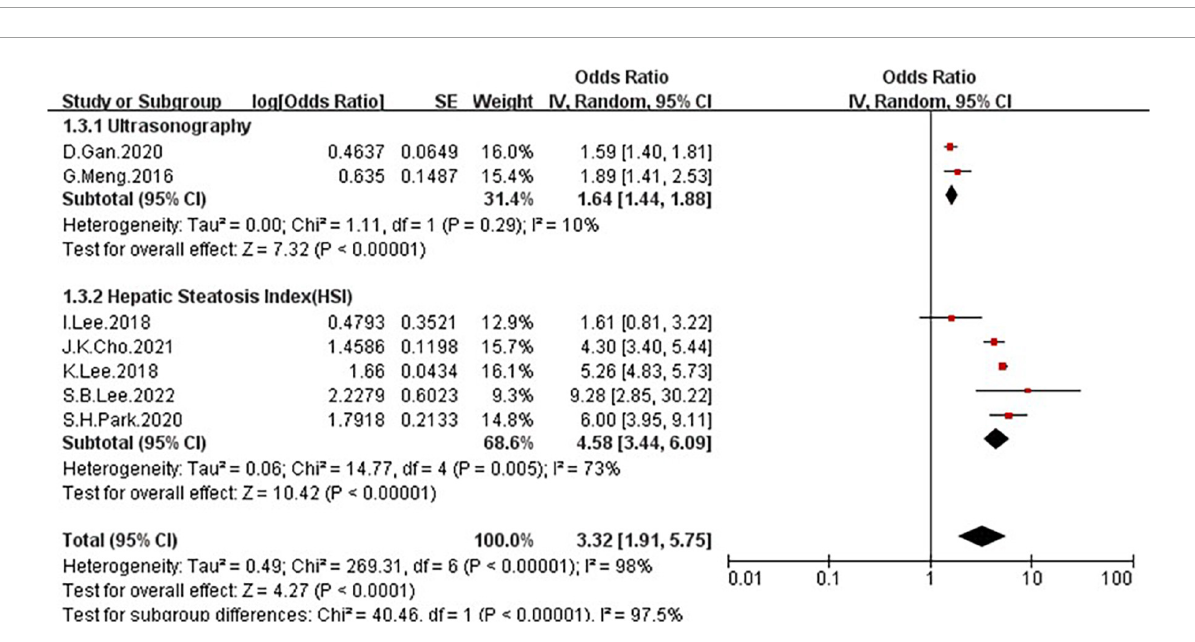
FIGURE7 Forest plots depicting the association of low grip strength and the risk of NAFLD were subgrouped by the diagnosis of